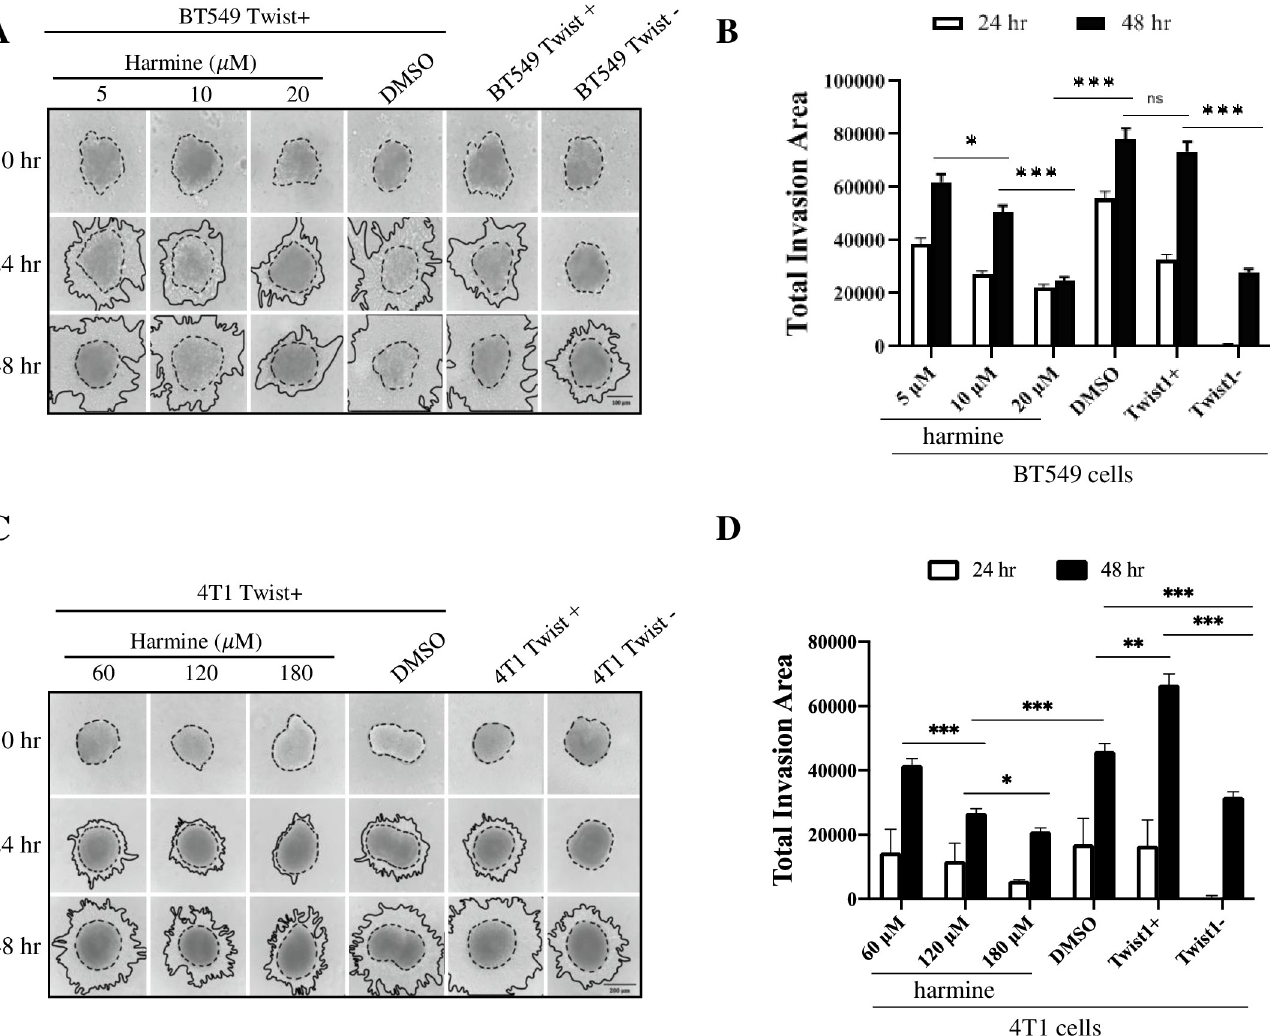
Fig 2. Harmine inhibits the invasion of breast cancer cells. The invasiveness of breast cancer cells was studied in a 3D setting (see Materials and Methods). A, BT549 cells were treated with harmine (5, 10, 20 μ M) or DMSO (solvent control) and images were captured at different time points (0, 24 and 48 hr). Untreated BT549 Twist+ and BT549 Twist- cells were included as positive and negative controls, respectively. Images are from a single experiment. B, quantitative analysis of results from three independent experiments including the one shown in A. Statistical significance was determined based on data from 48 hr. C, 4T1 cells were treated with harmine (60, 120, 180 μ M) or DMSO (solvent control) and images were captured at different time points (0, 24 and 48 hr). Untreated 4T1 Twist+ and 4T1 Twist- cells were included as positive and negative controls, respectively. Images are from a single experiment. D, quantitative analysis of results from three independent experiments including the one shown in C. Statistical significance was determined based on the data from 48 hr. Definitions of statistical significance are � p < .05, �� p < .01, ��� p < .001, and ���� p < .0001.